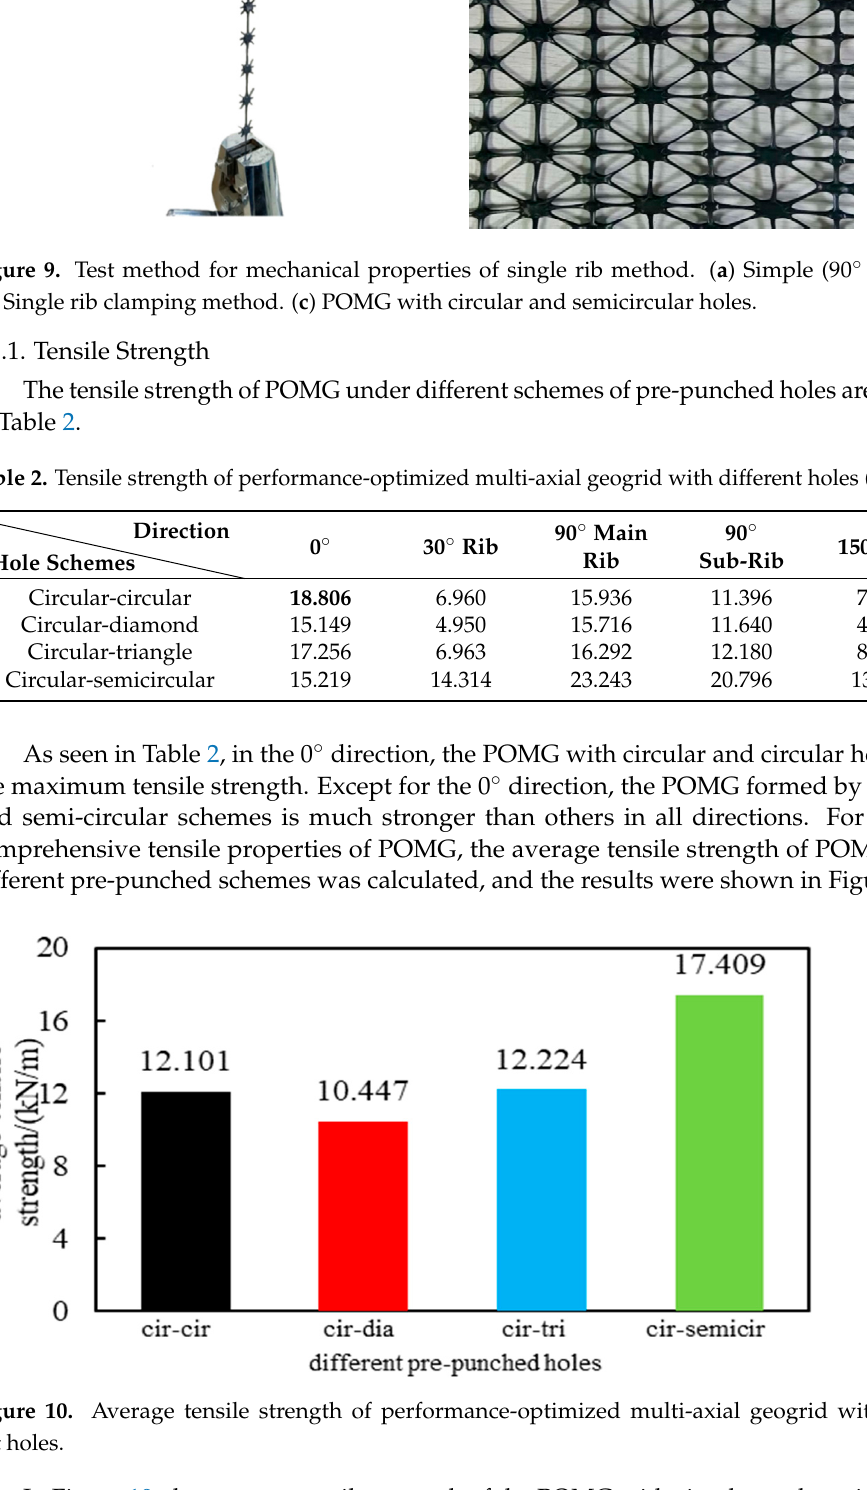
Figure 9. Test method for mechanical properties of single rib method. ( a ) Simple (90° sub-rib). ( b ) Single rib clamping method. ( c ) POMG with circular and semicircular holes.